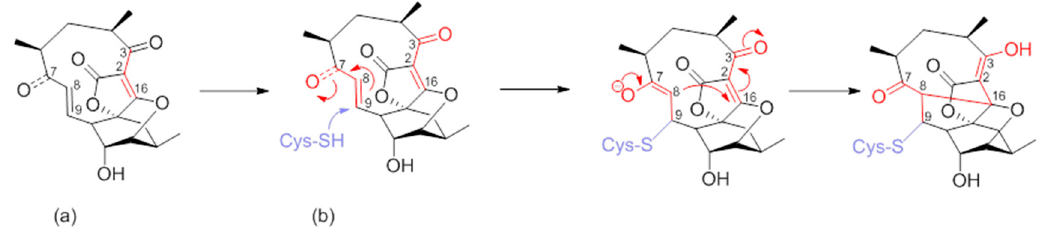
Figure 7. ( a ) Atrop-abyssomicin C; and ( b ) irreversible inhibition of PabB via double Michael addition (Michael acceptors in red) (modified from [63]).